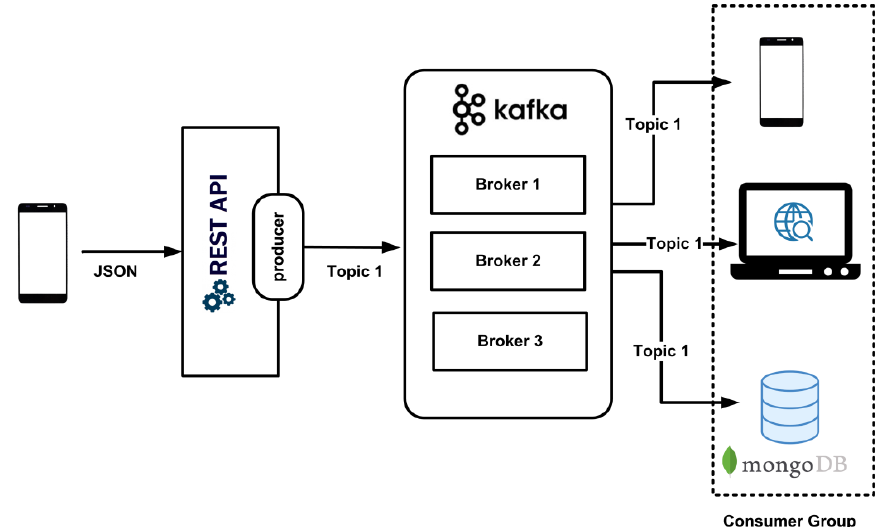
Figure 2. System design of the real ‐ time data processing.